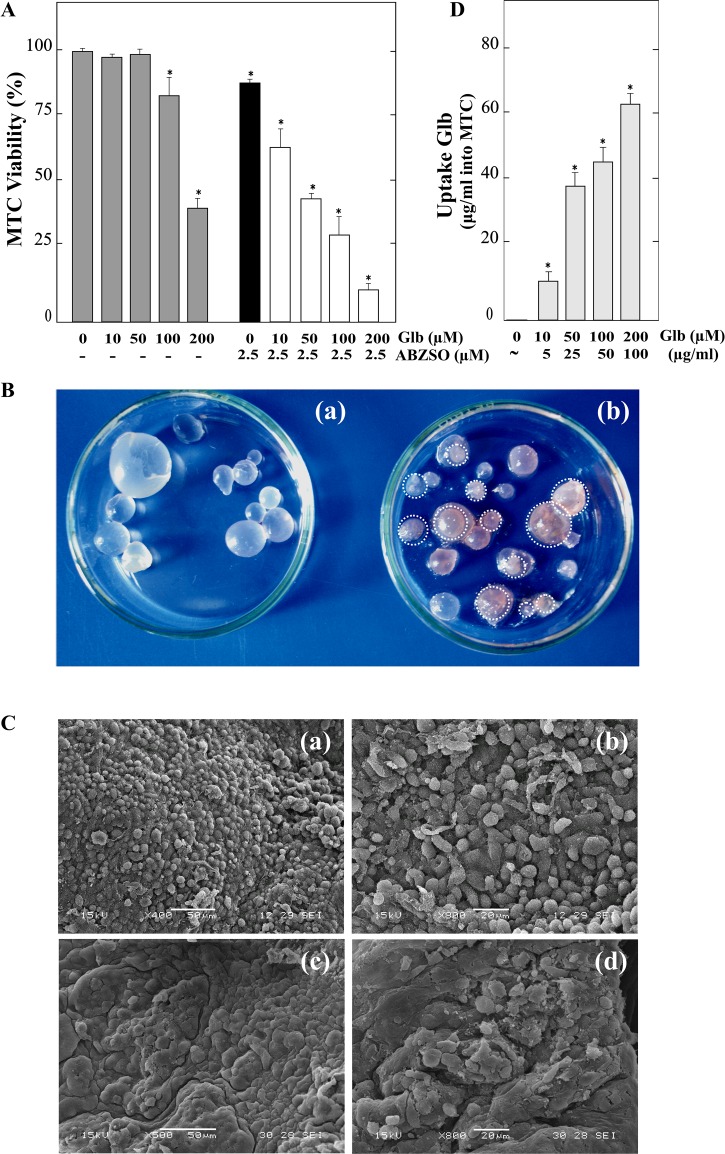
In vitro effect of glibenclamide and its combination with albendazole sulfoxide on viability of E. granulosus metacestodes.(A) Viability of metacestodes (MTC) incubated for 5 days with 10, 50, 100 and 200 μM of glibenclamide alone (Glb), 2.5 μM albendazole sulfoxide alone (ABZSO) and 10, 50, 100 and 200 μM Glb plus 2.5 μM ABZSO in combination. Parasites incubated in culture medium containing DMSO served as controls. Data are the mean ± S.D. of three independent experiments. *Statistically significant difference (p < 0.05) compared with the appropriate control (without drug or ABSZO alone). (B) Macroscopic damage in metacestodes exposed to glibenclamide. Control metacestodes (a) without morphological changes and metacestodes treated with 200 μM Glb for 5 days (b) showing increased permeability and collapsed germinal layer (circles). (C) Representative SEM images of control metacestodes (a, b) and treated with 200 μM glibenclamide for 5 days (c, d). (a, b) Control metacestode with an intact germinal layer; (c, d) Treated metacestode with altered germinal layer. Bars indicate: 50 μm in (a) and (c), and 20 μm in (b) and (d). (D) Intracystic concentrations of Glb from cysts incubated with 10, 50, 100 and 200 μM Glb in the experiment indicated in (A). *Statistically significant difference (p < 0.05) compared with control.